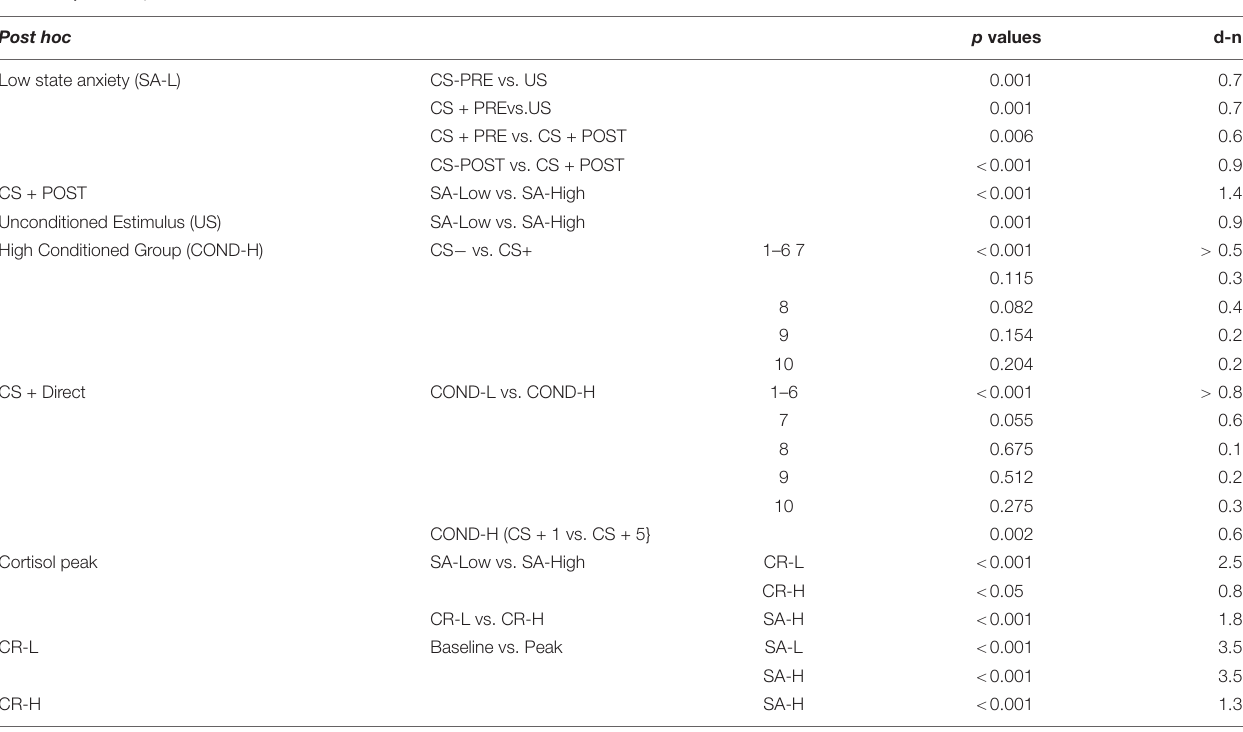
TABLE 2 | General post hoc table of the different mixed